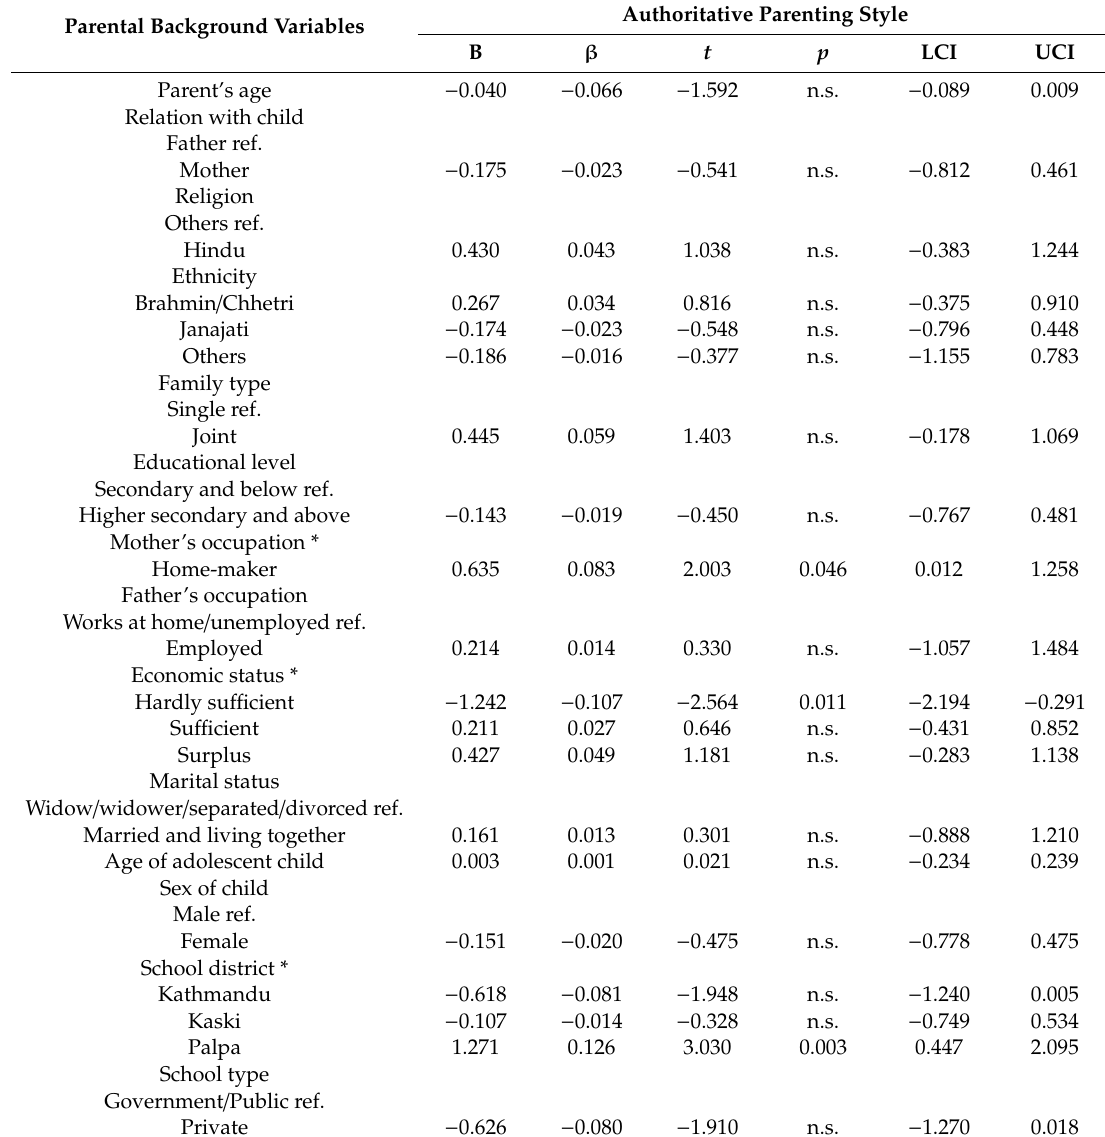
Table 5. Linear regression coe ffi cients and level of significance of the factors associated with authoritative